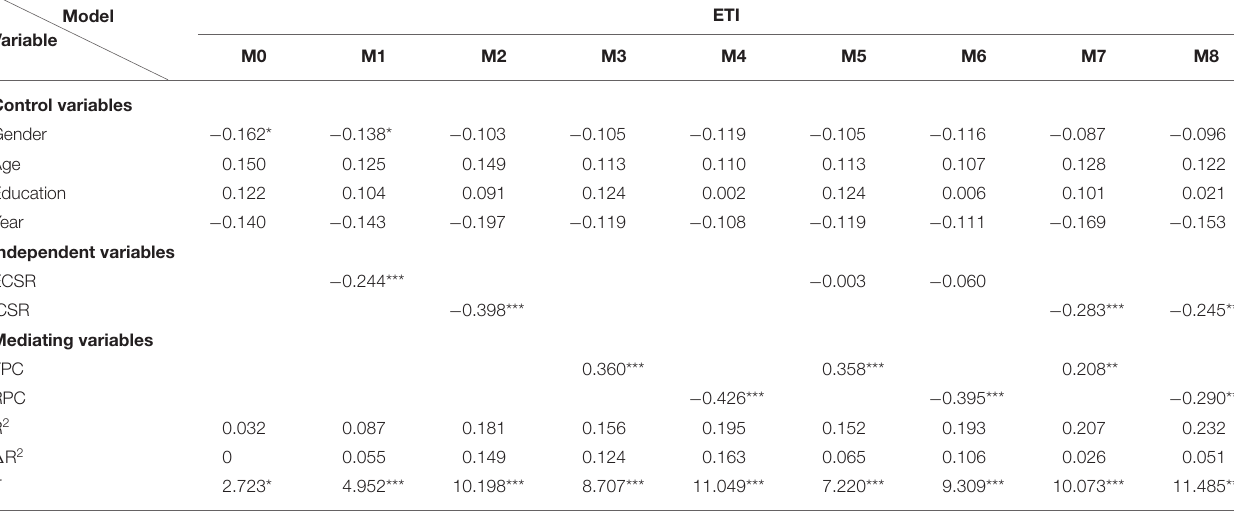
TABLE 4 | The impact of corporate social responsibility on psychological contract.